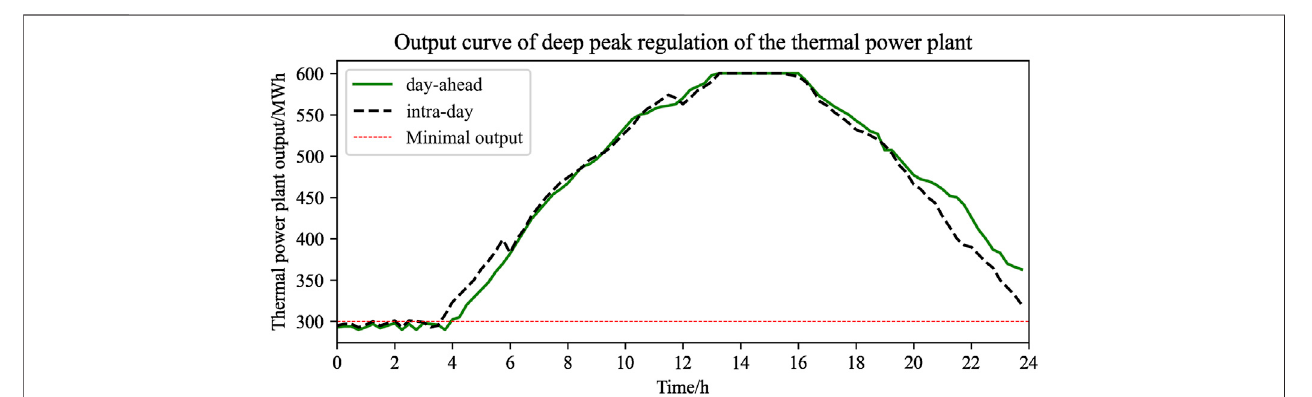
FIGURE 8 | The output power curve of the deep peak regulation of the thermal power plant.